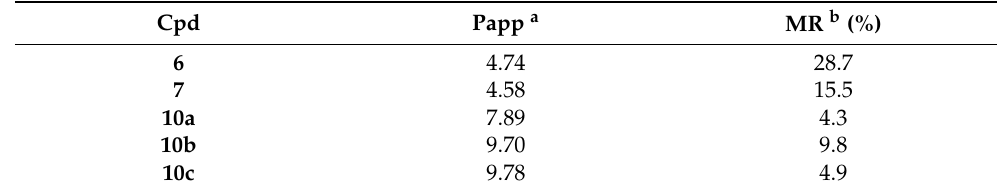
Table 3. In vitro PAMPA permeability studies of compounds 6 , 7 , 10a–c . Cpd Papp a MR b (%)